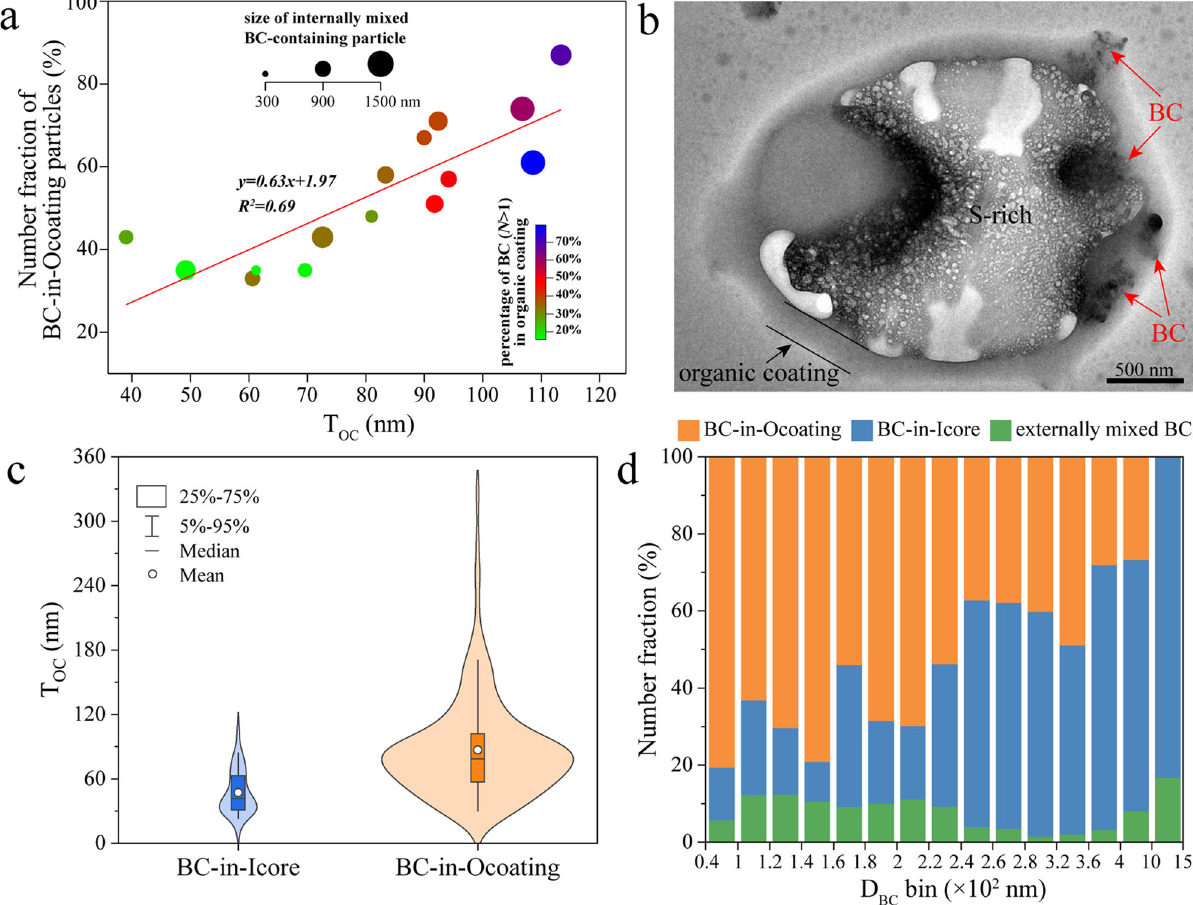
Fig. 3 Organic coating thickness (T OC ) and size distribution of BC within individual particles in the background air. a Correlation between T OC and number fraction of BC-in-Ocoating particles in internally mixed BC-containing particles. The color bar represents the percentage of BC-in-Ocoating particles containing multiple BC in all the BC-in-Ocoating particles. b A typical TEM image of BC-in-Ocoating particle containing four tiny BC particles. c T OC of BC-in-Icore and BC-in-Ocoating particles. The blue and orange shadows represent the distribution of the T OC data. d Number fractions of BC-in- Ocoating, BC-in-Icore, and externally mixed BC particles in different BC diameter (D BC ) bins from 40 nm to 1500